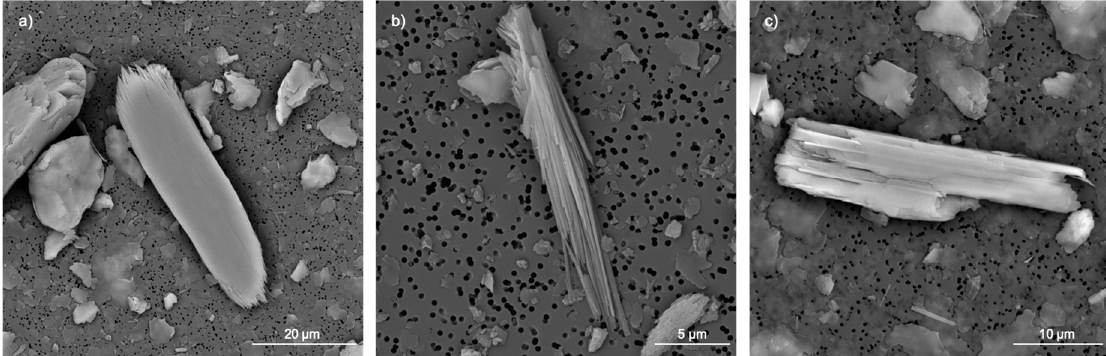
Figure 4. SEM microphotographs of outlier fibers. Examples from ( a ) serpentinite; ( b ) debris; and ( c ) soil. (High Vacuum; 20 kV; magnification: 4000×, 1200×, 7000×; Detector: Back scattered electrons).